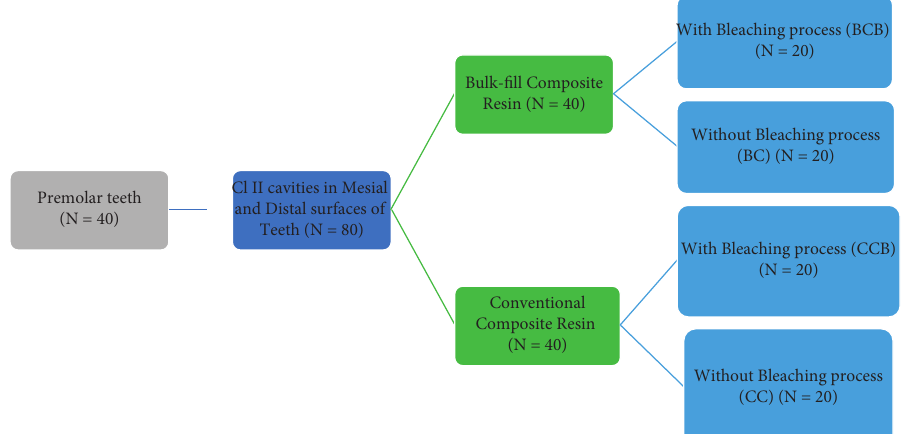
Figure 1: The study design (the materials and